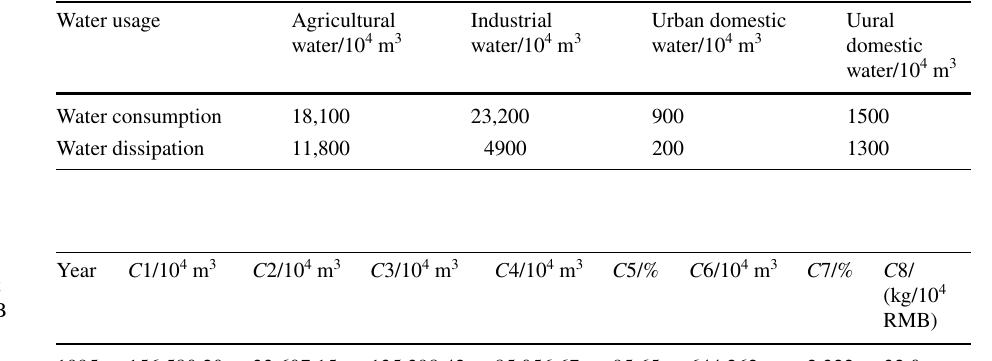
Table 1 Average values of water usage in the Fuyang district (ZWRD 1998–2003)